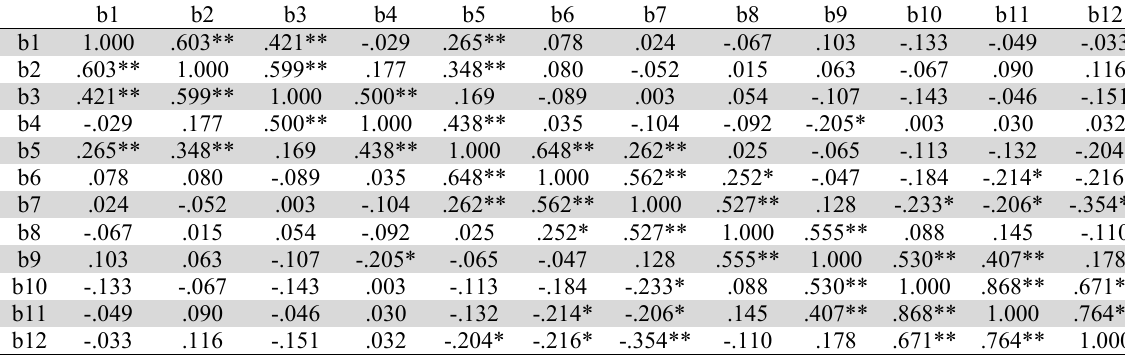
Correlation Coefficients for QT&T